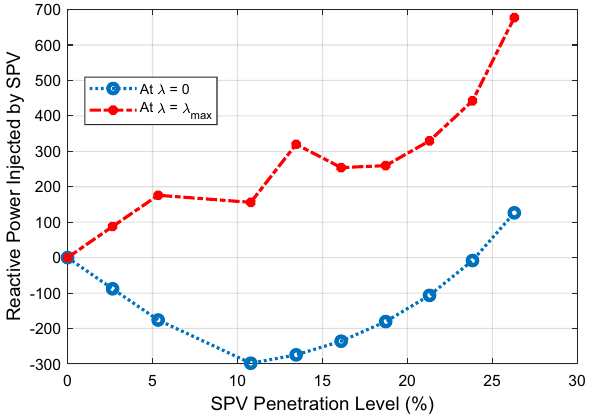
Figure 9. Reactive power injected by the SPV.